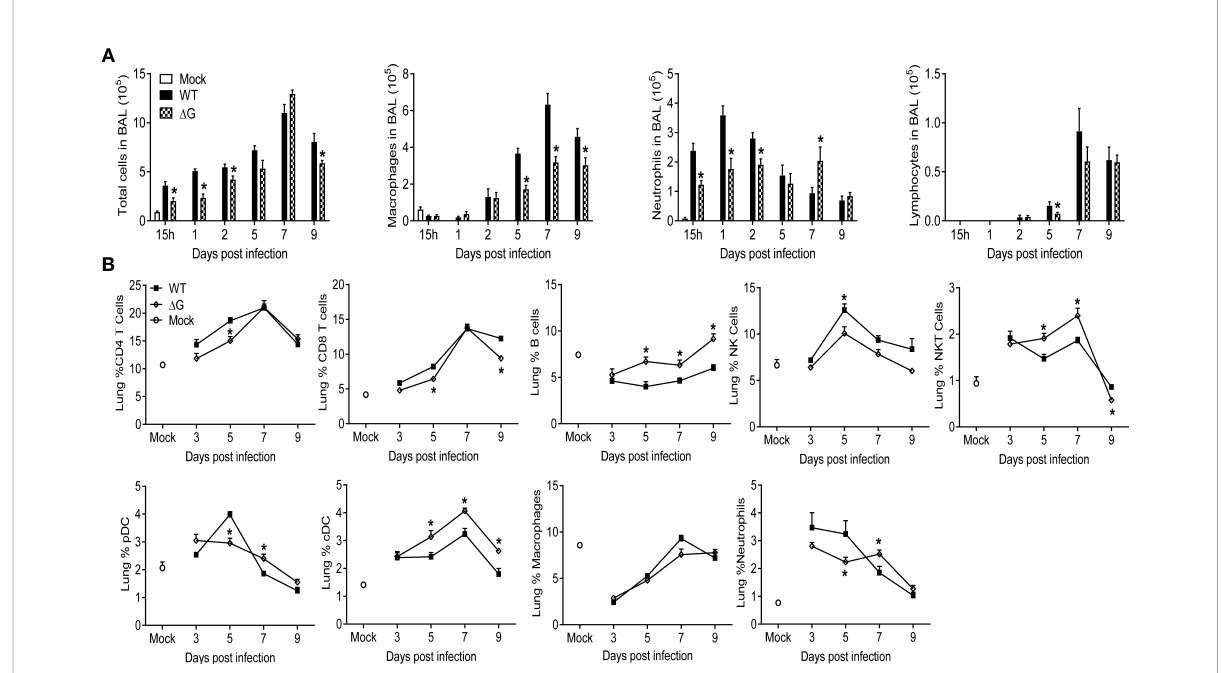
FIGURE 3 Cell recruitment in BAL and lung tissue. Mice were either infected with rhMPV-WT or rhMPV- D G/WT or mock-infected and sacri fi ced at various time points p.i. to collect BAL fl uid and lungs. (A) BAL fl uid was subjected to cytospin and analyzed for total and differential cell counts. (B) Cells were isolated from lungs and stained for cell-type speci fi c CD markers and live cells analyzed by fl ow cytometry. Data are expressed as mean ± SEM of four mice/group and is representative of one of three independent experiments. * P<0.05 when comparing rhMPV- D G infected mice